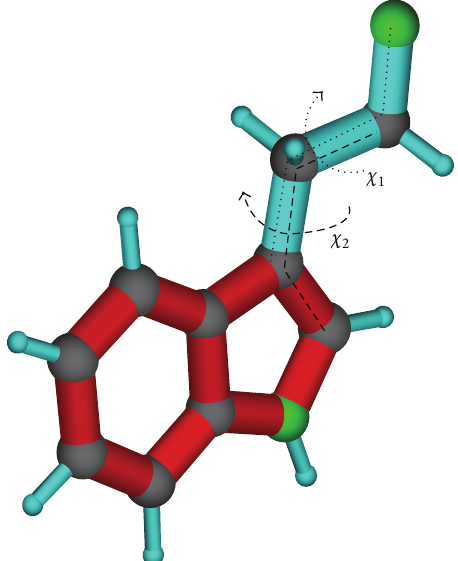
Figure 5: The side chain torsion angles of TRP-41: 𝜒 1 ( N , C 𝛼 , C 𝛽 , C 𝛾 ) and 𝜒 2 ( C 𝛼 , C 𝛽 , C 𝛾 , C 𝛿1 )